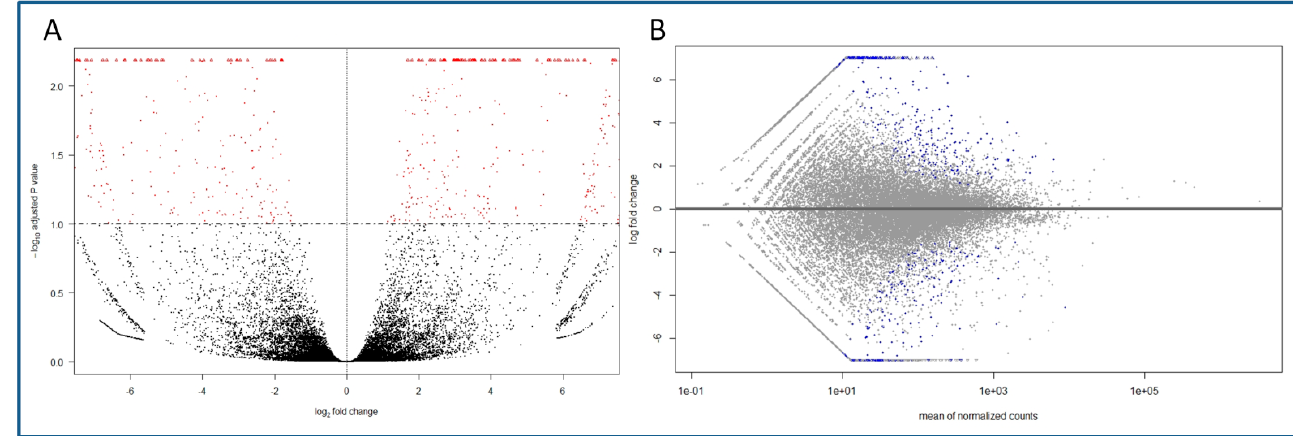
Figure 1. Overall results of the gene expression in the transcriptomics analysis of the BS and CR libraries, and identification of differentially expressed genes (DEGs). ( A ) Volcano plot showing the DEGs in CR samples (right, log2FC > 0) and BS samples (left, log2FC < 0) and the adjusted p value (<0.1). Red dots indicate DEGs for one condition or the other. ( B ) MA plot of the log2FC of the different genes versus the mean of normalized counts. Blue dots indicate DEGs (adjusted p value < 0.1).